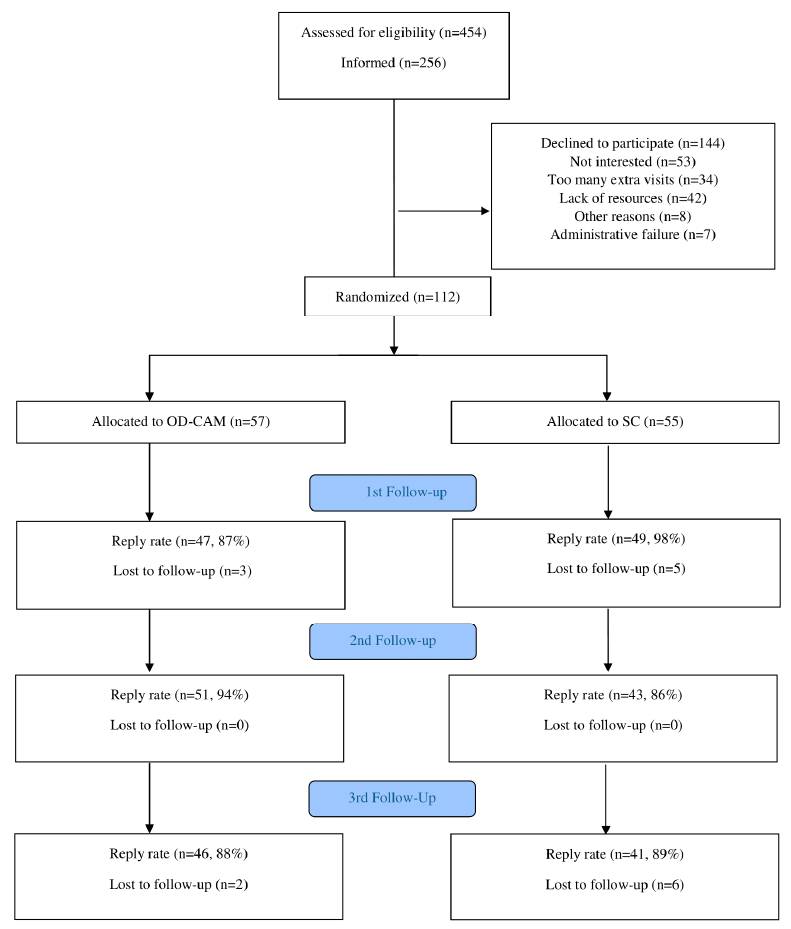
Figure 1. Flow Figure 1. Flow Diagram. Table 2. Baseline Sociodemographic and Clinical Characteristics ( n = 112).